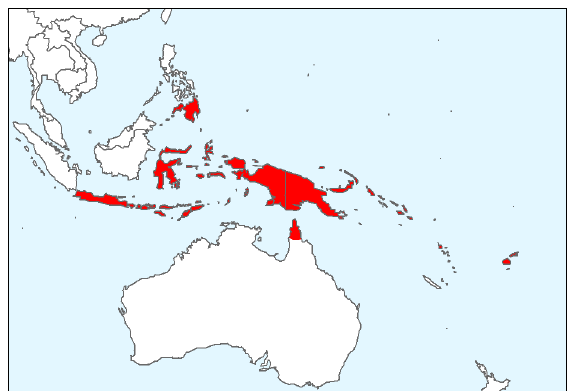
Fig. 2. Map of the native range of Codiaeum variegatum